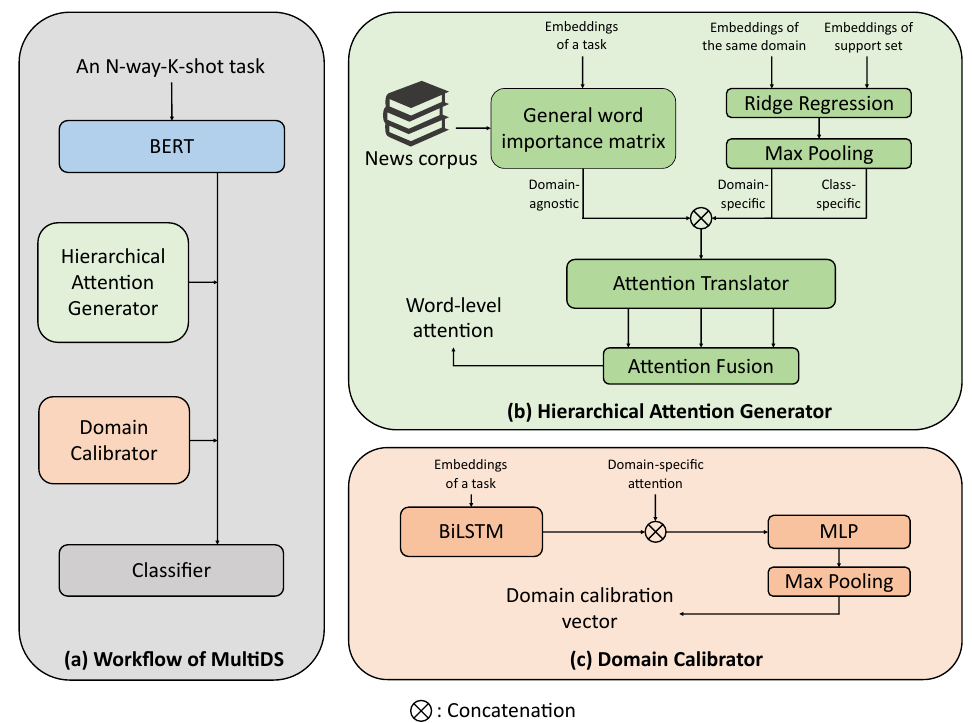
Figure 2. ( a ) The workflow of MultiDS model. ( b ) Hierarchical attention generator. ( c ) Domain